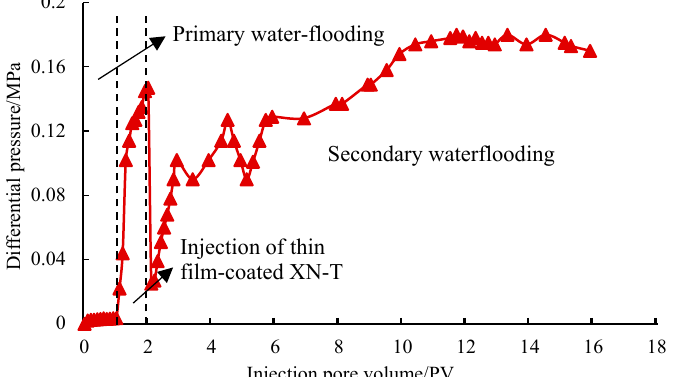
Figure 7. Profile control performance evaluation of the thin film-coated XN-T.